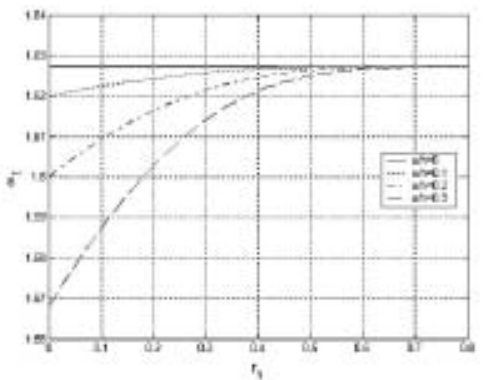
Fig. 4. The first structural frequency parameter of the coupled system as a function of the position of the crack. The fluid is considered compressible without sloshing.